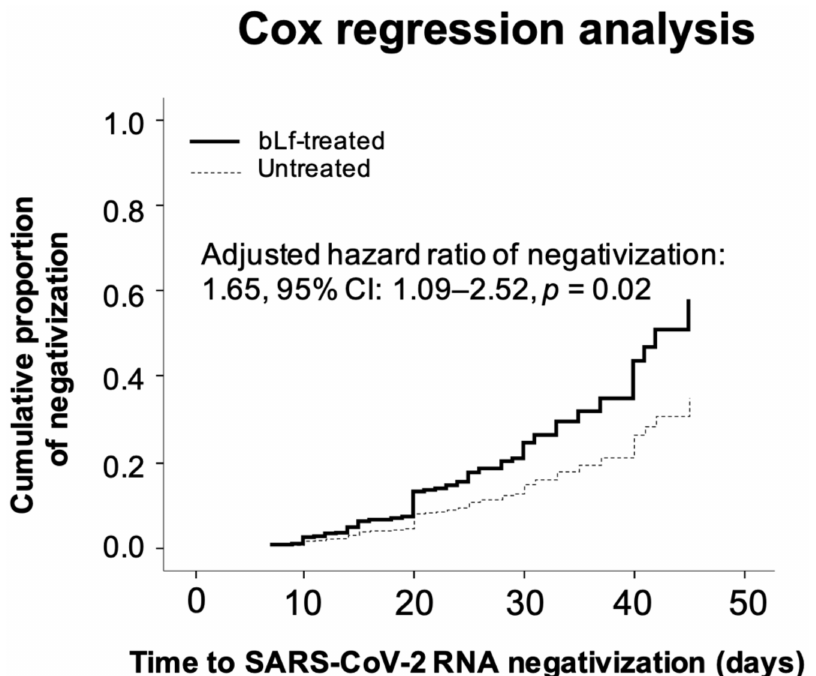
Figure 5. Cumulative proportion of SARS-CoV-2 RNA negativization as a function of time in patients treated and untreated with bovine lactoferrin (bLf), adjusted for confounders included in Table 2b. Data are presented as adjusted hazard ratio, 95% confidence interval (CI), and p